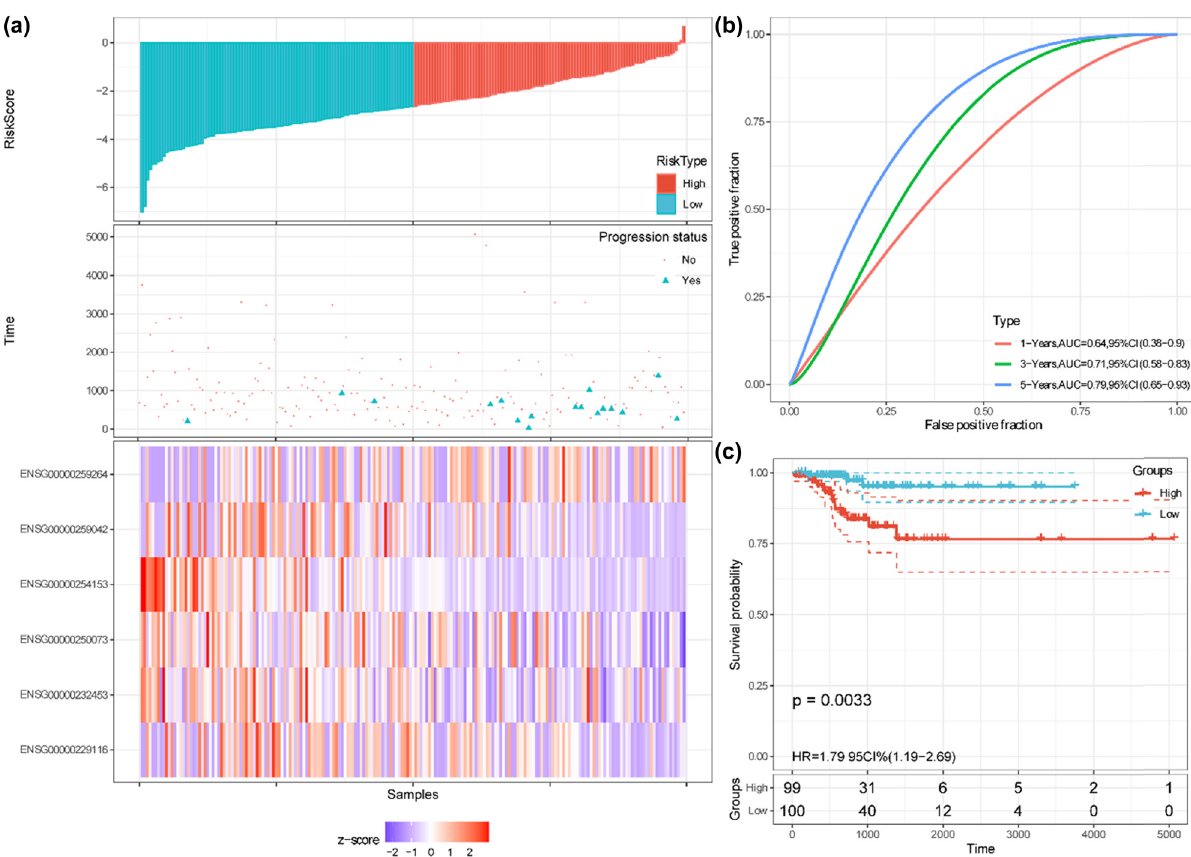
Figure 6: Predictive performance of the six autophagy - related lncRNAs signature in the validation cohort. ( a ) Risk scores, PFI/progression status, and expression heatmap. ( b ) Time - dependent ROC curves for predicting 1 - , 3 - , and 5 - year PFI based on the risk scores. ( c ) Kaplan – Meier curves of the patients with high and low - risk scores, which were divided by the median value of the risk